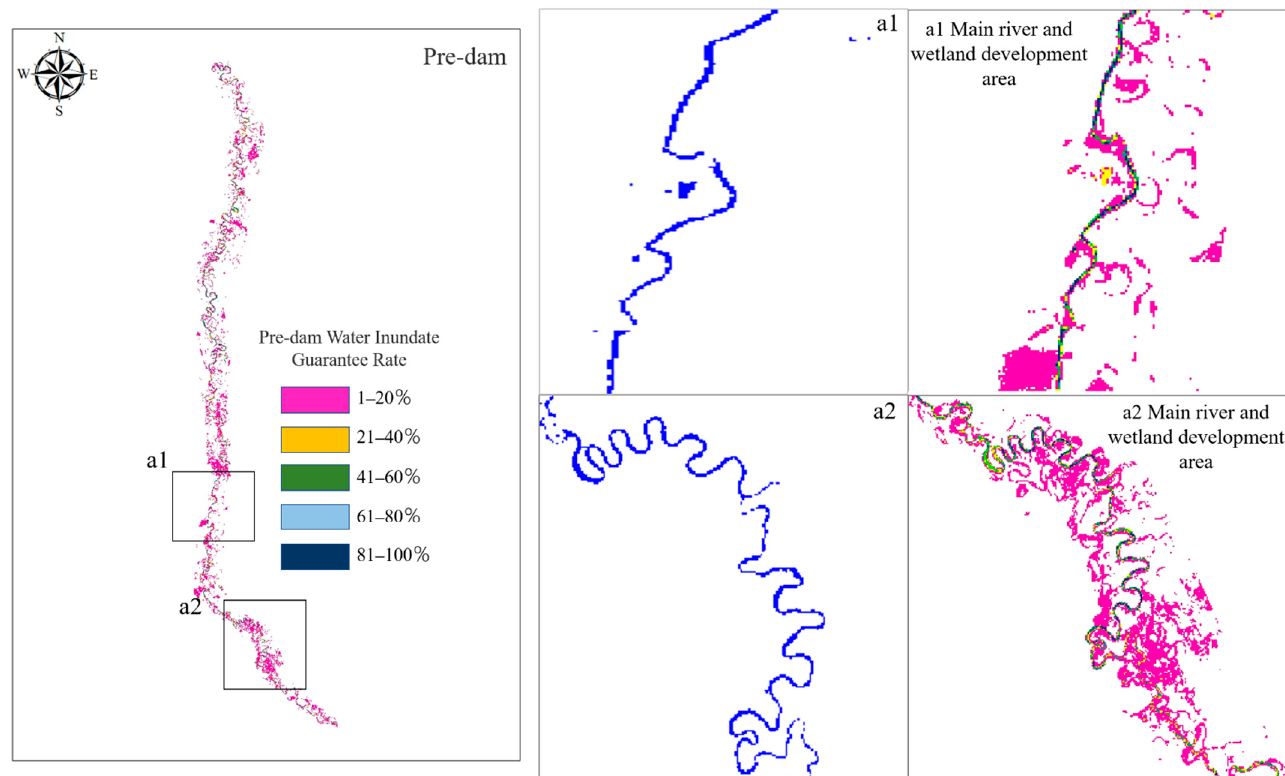
Figure 7. Pre-dam differences the submerged state between the highly curved river segment and the straight river segment.